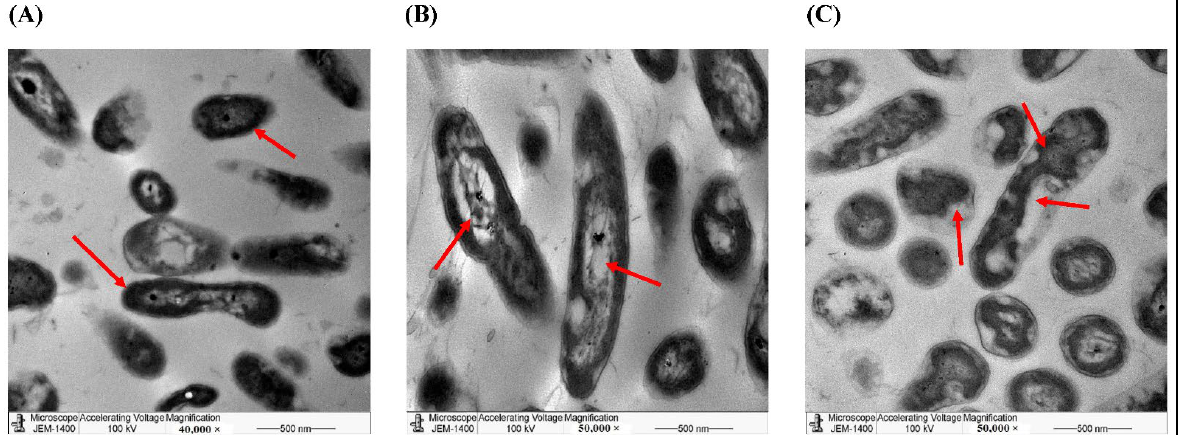
Figure 7. TEM imaging of P. aeruginosa showing the morphological changes with different treatments. P. aeruginosa cells were either ( A ) non-treated (Control), ( B ) treated with AgNPs of the aqueous extract (10 mg/mL), or ( C ) treated with AgNPs of the ethanolic extract (10 mg/mL). Arrows indicated some morphological differences.